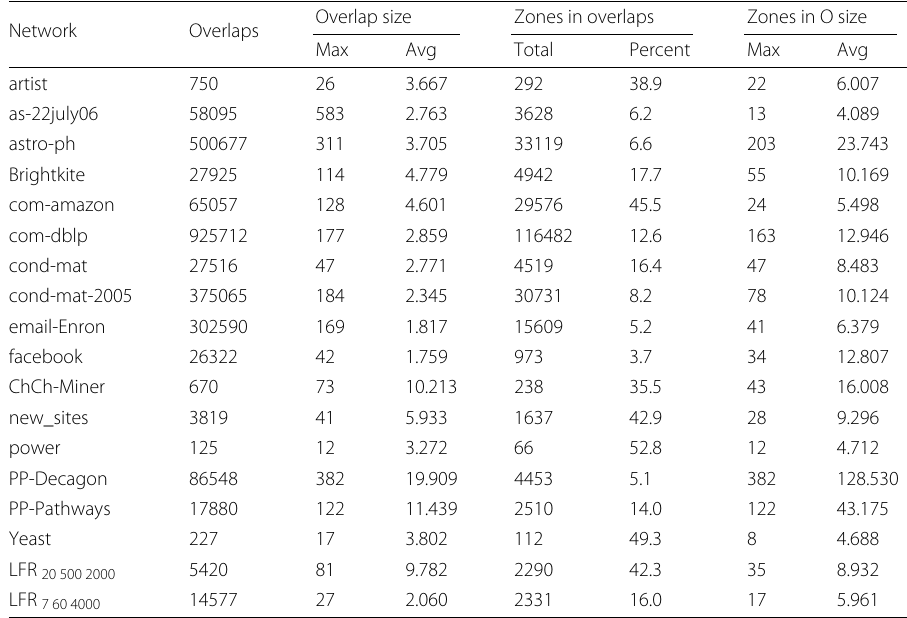
Table 15 Properties of zone overlaps in real-world networks